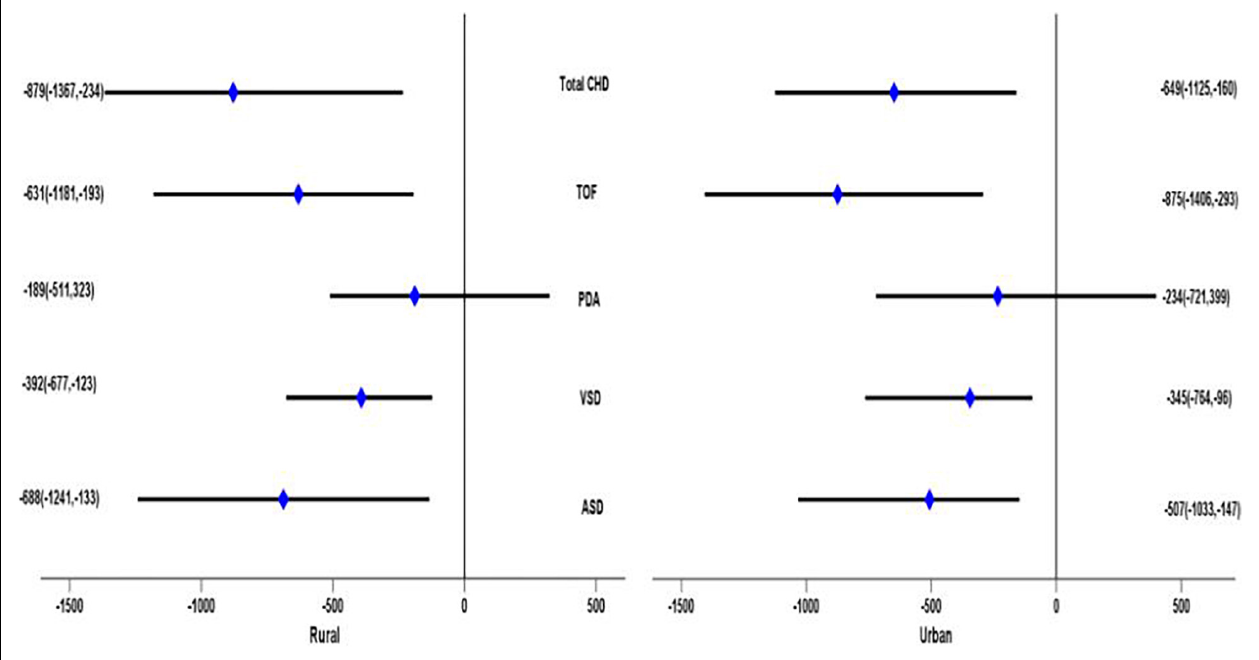
FIGURE 2 | Adjusted β value and 95% CI of the relationship between different subtypes of congenital heart disease and birth weight in children of different places of residence (results of Model 3).